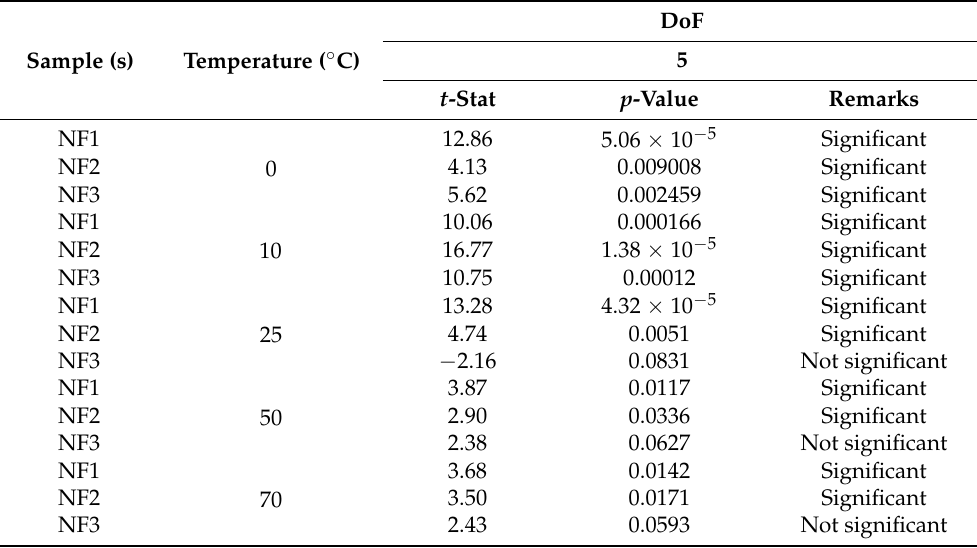
Table 2. Statistical significance on dynamic viscosity measurements using the student t -Test for mean at a confidence interval of